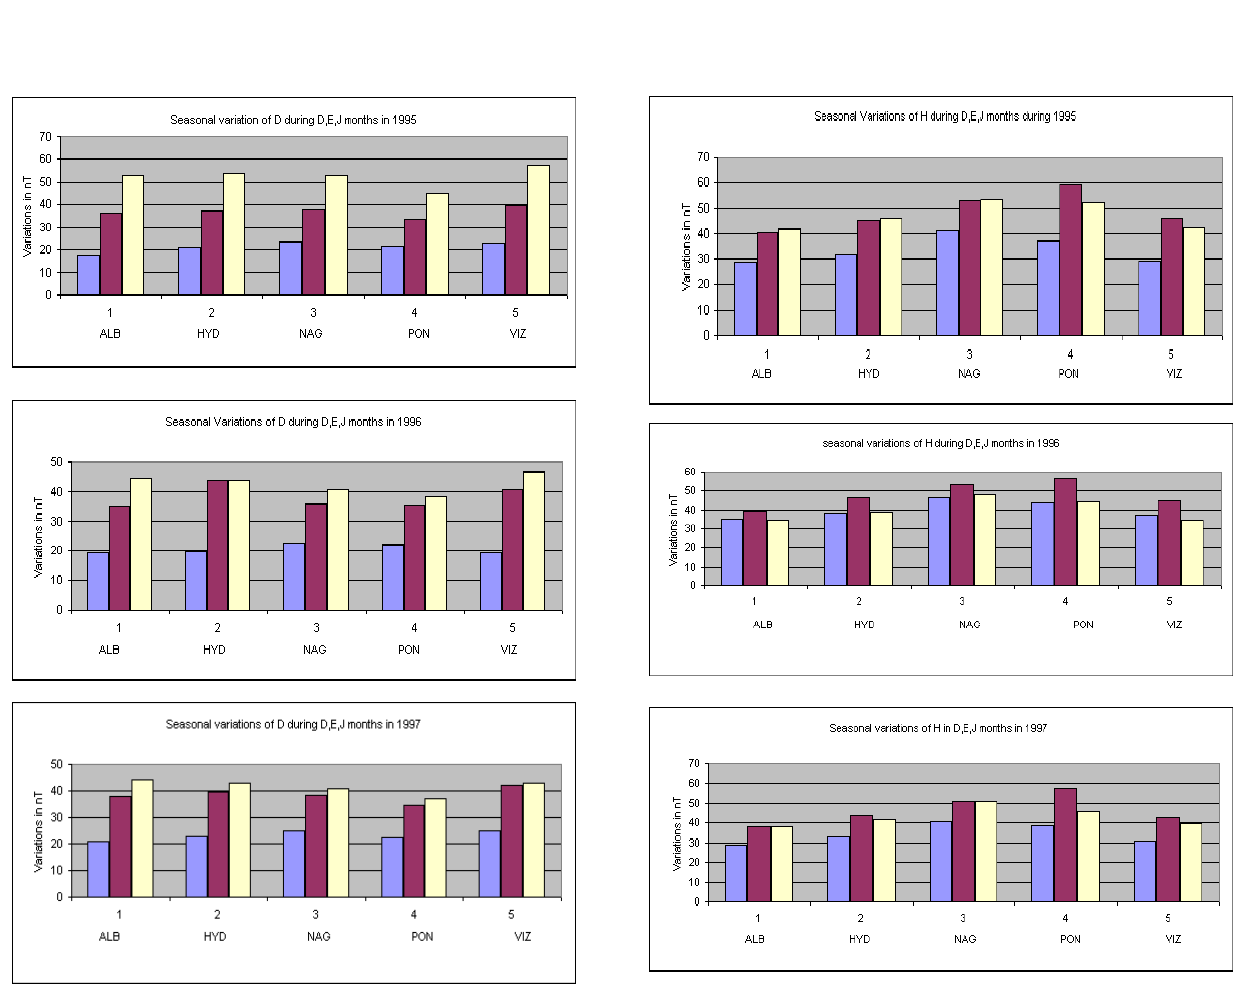
Fig. 1. Seasonal variations of the declination D-component during D, E, J months.